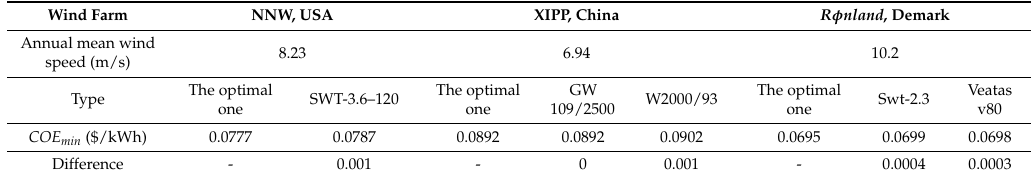
Figure 9. The results of the objective function (COE) and optimal layout: ( a ) results of objective function, ( b ) optimal layout of Swt-2.3-93, and ( c ) optimal layout of Vestas v80-2.0MW. Table 6. The results of minimum COE corresponding to the optimal